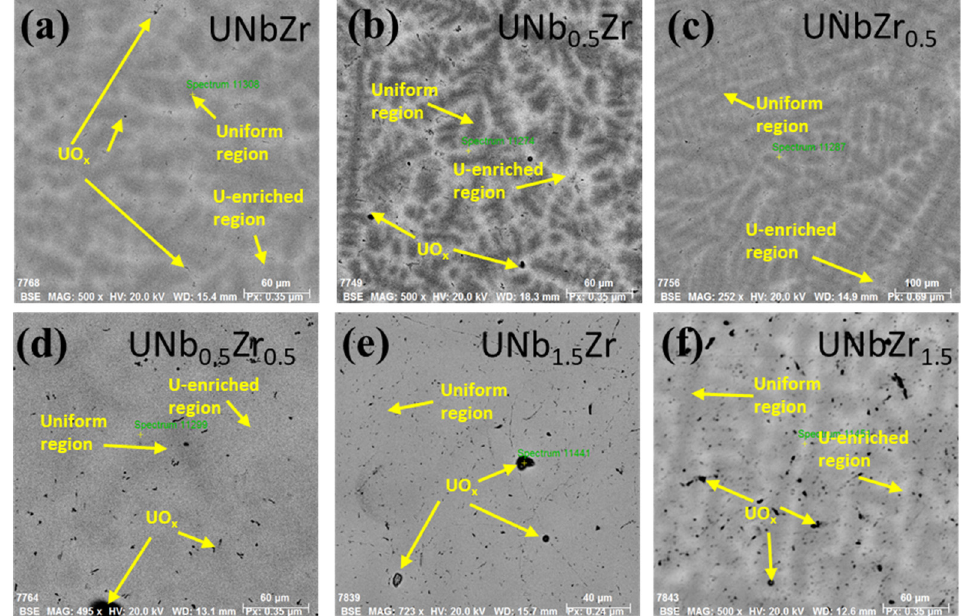
Figure 5. SEM images of the U-Nb-Zr system alloys. ( a ) UNbZr, ( b ) UNb 0.5 Zr, ( c ) UNbZr 0.5 , ( d )